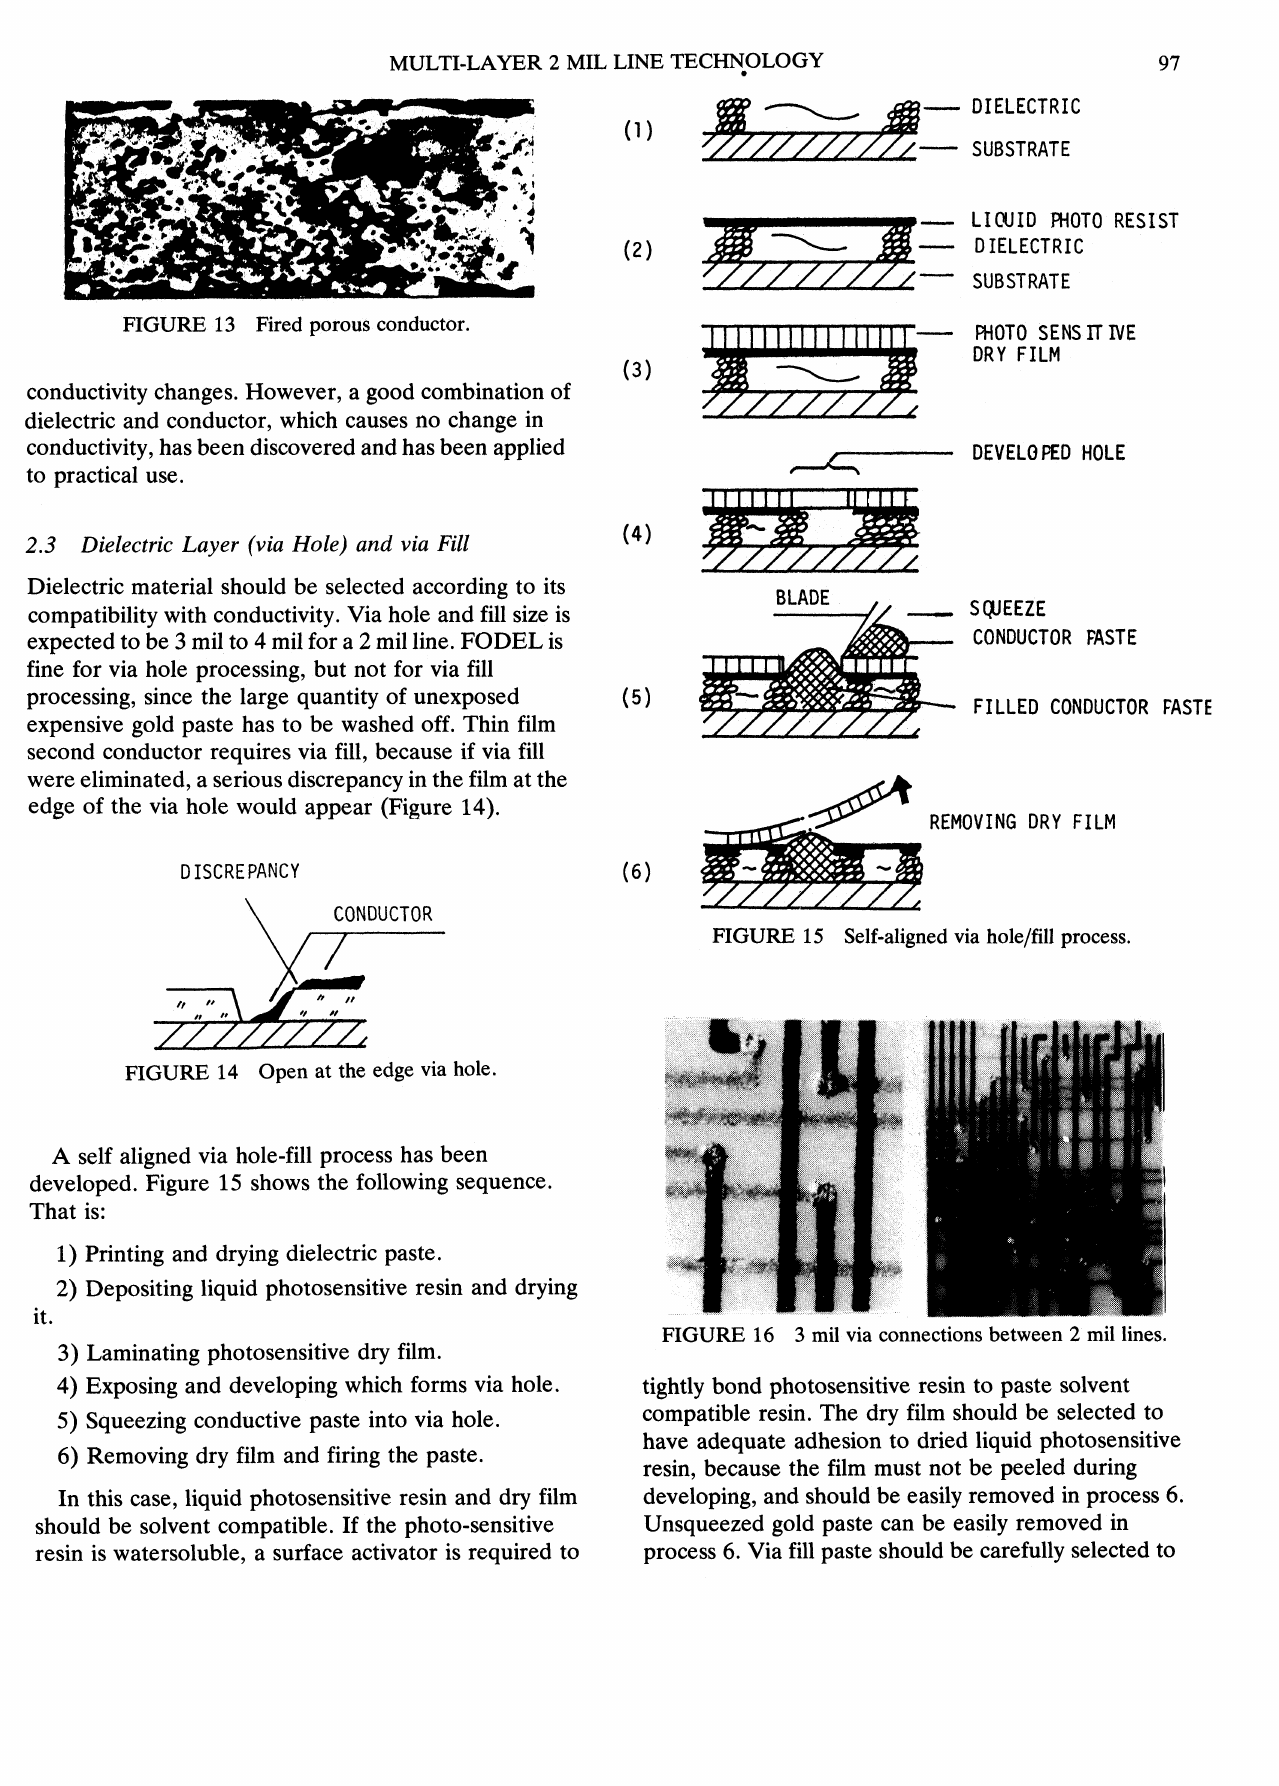
FIGURE 13 Fired porous conductor.